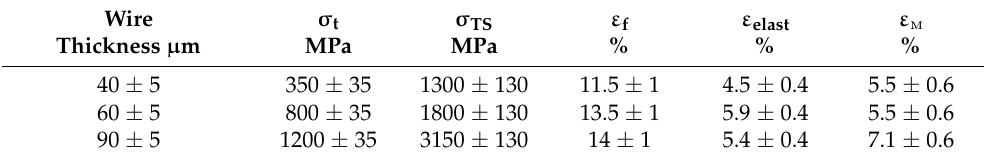
Table 2. Mechanical characteristics of NiTi